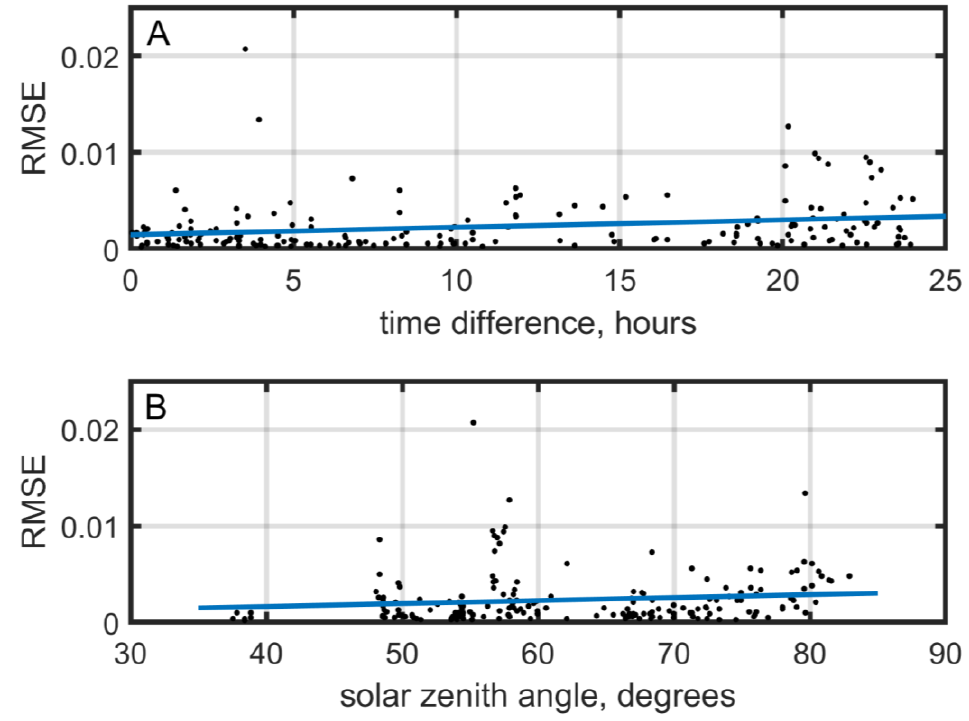
Figure 7. Dependences of the average RMSE of the R rs values on the absolute difference between the time of the in situ and the satellite measurements ( A ) and on the zenith angle of the sun ( B ). The blue lines show the trend assessment.